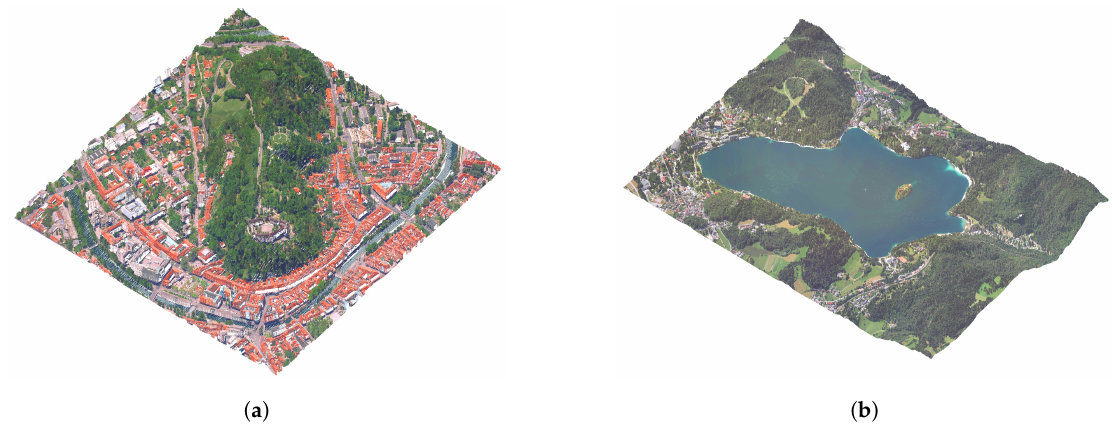
Figure 5. Results of the water surface reconstruction algorithm for examples from Figure 3: reconstructed river in Ljubljana city centre ( a ), and reconstructed Lake Bled surface ( b ).